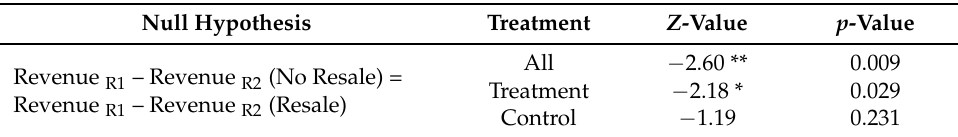
Table 4. Wilcoxon tests of treatment effects and allowance resale. Null Hypothesis Treatment Z -Value p